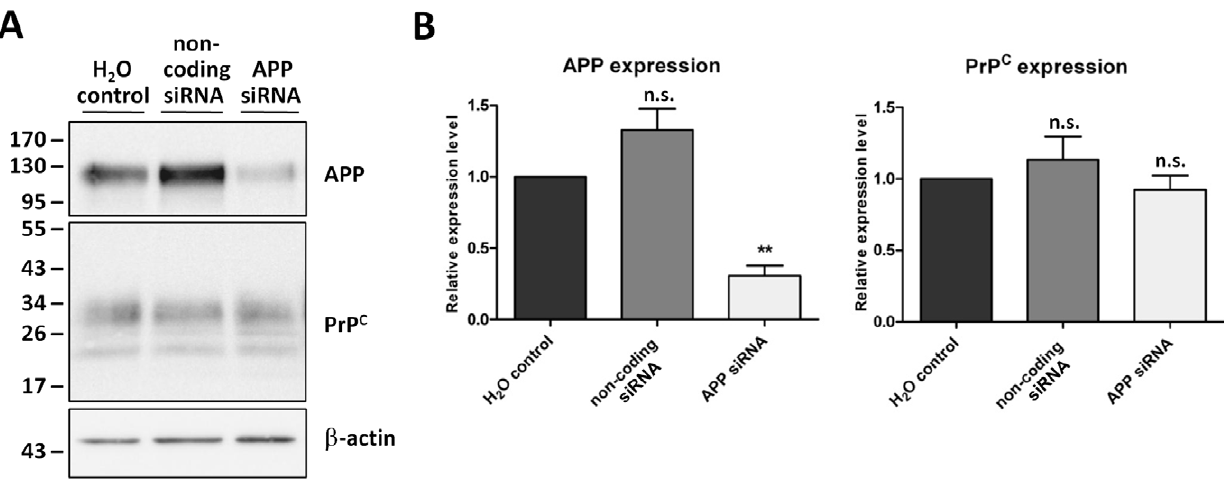
Figure 4. Knockdown of APP expression in N2a cells has no effect on PrP C protein levels. (A) Representative western blots of APP and PrP C (antibody 6H4) in N2a cells treated with APP directed siRNA, non-coding control siRNA, and a no RNA transfection control (H 2 O control), and subsequent b -actin staining. Approximate molecular weights (kDa) are indicated. (B) Quantification of APP and PrP C protein levels expressed relative to the H 2 O control cells. Data from 3 independent experiments. Statistical analysis by one way ANOVA with Dunnett’s post test comparison to the H 2 O control cells, **p , 0.01, n.s. not significant.